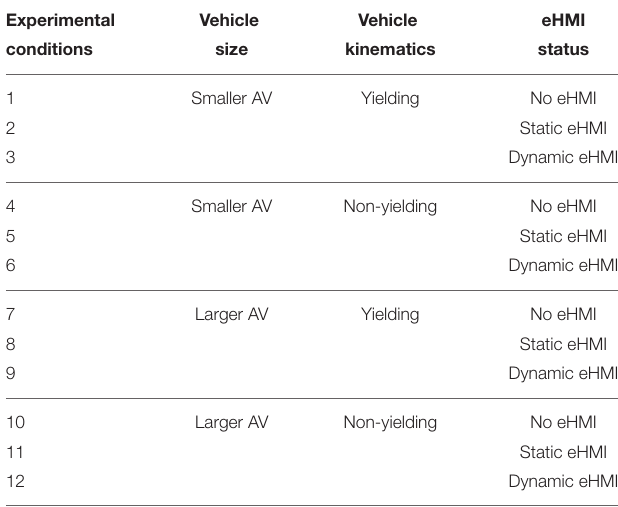
TABLE 1 | Overview of this study’s experimental conditions presented in the short video sequences (presented in randomized order).